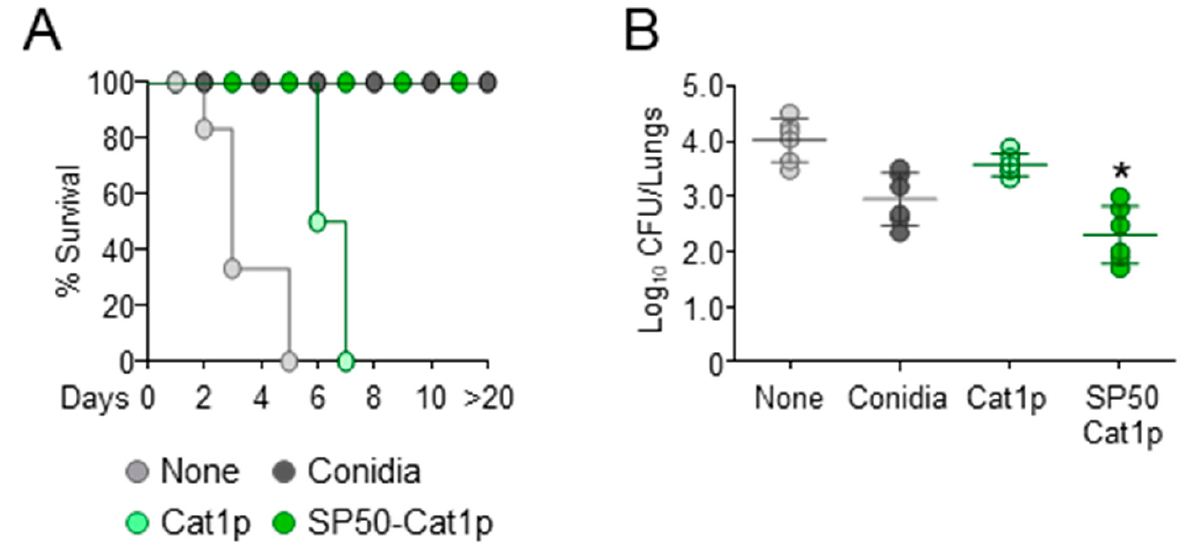
Figure 1. Vaccinating potential of SP50 against invasive pulmonary aspergillosis. C57BL/6 mice were injected intranasally with 2 × 10 7 Aspergillus conidia 14 days before (Conidia) or with Ag (Cat1p), with and without SP50, and CpG (10 nM) 14, 7, and 3 days before the intranasal infection with 2 × 10 7 live, resting conidia. Mice were immunosuppressed i.p. with 150 mg/kg cyclophosphamide a day before infection. Mice were assessed for ( A ) survival, and for ( B ) fungal growth (Log10 CFU) in the lungs 3 days post-infection. Data are pooled from three independent experiments. None, infected mice. * p < 0.05, SP50-Cat1p-treated vs Cat1p-treated mice.